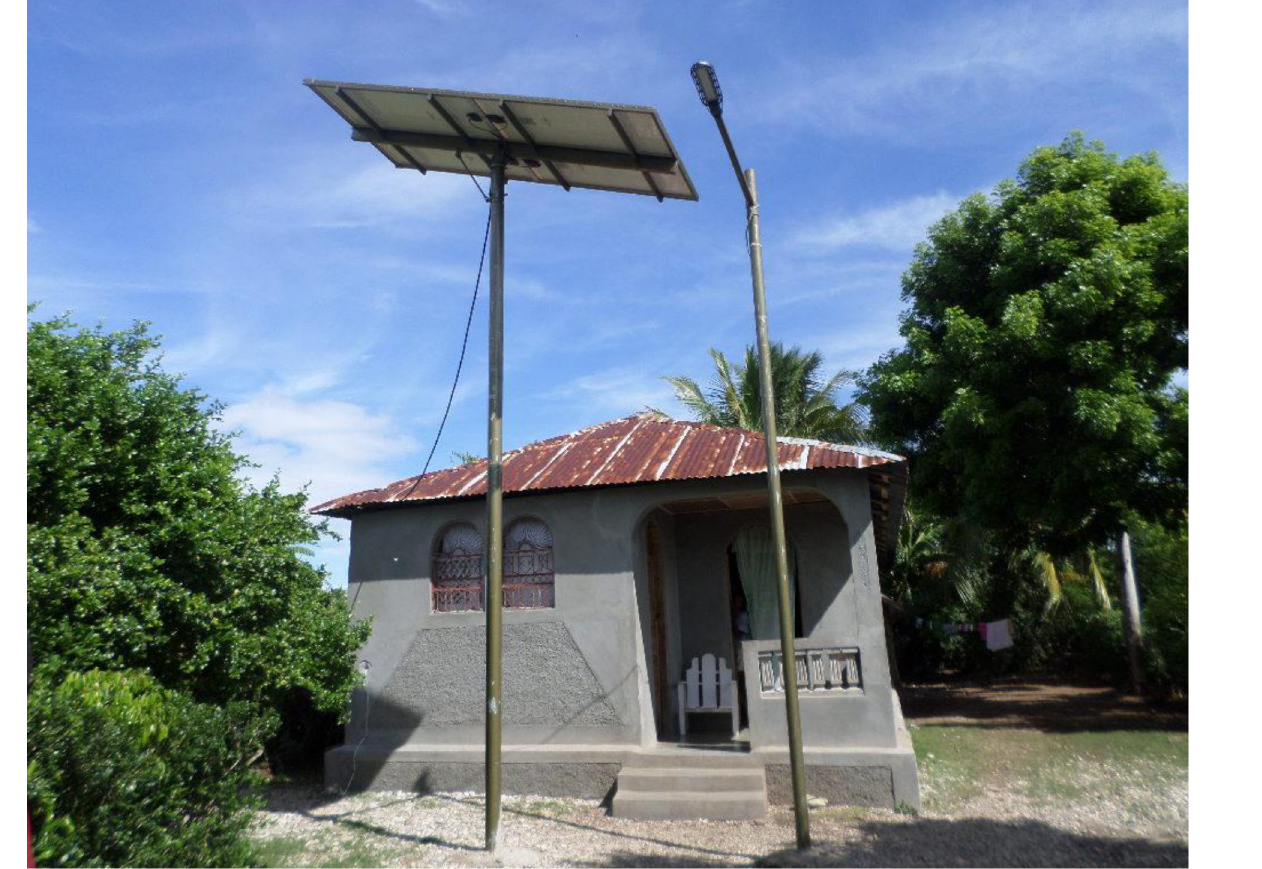
Fig 1. Solar panels at an outpost in Haiti. Electricity is fed to refrigerators inside the post to ensure cold chain for canine rabies